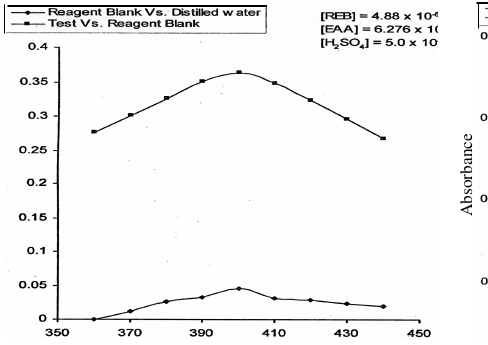
Figure 4 . Absorbance spectrum of REB – EAA–conc.H